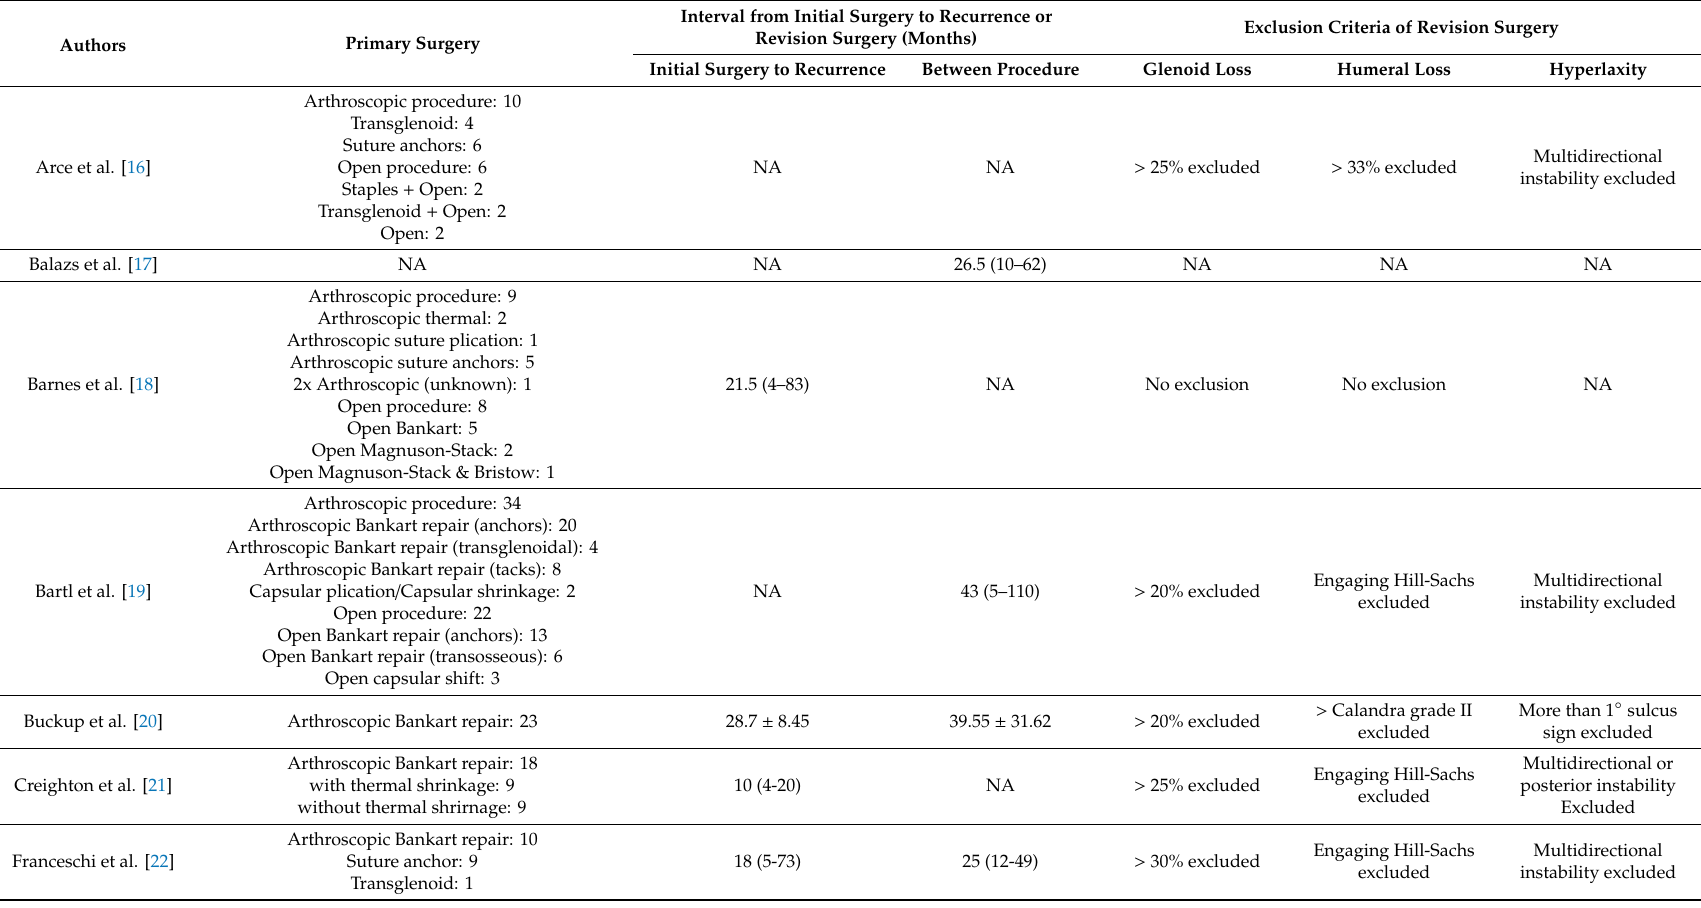
Table 3. Type of primary surgery and inclusion and exclusion criteria of revision